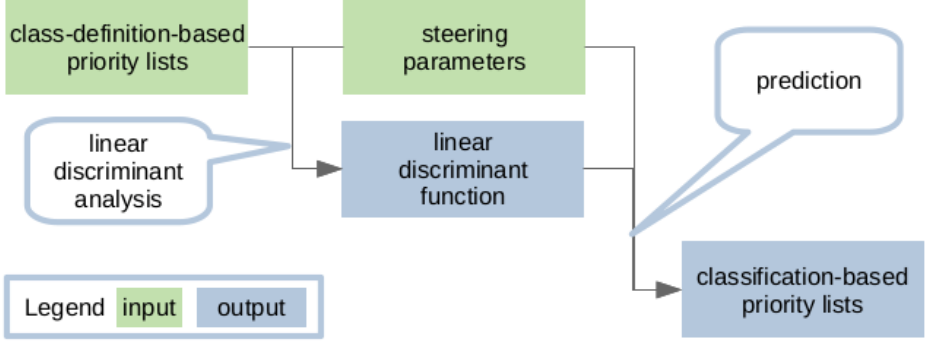
Figure 2. Obtaining a linear discriminant function and the classification-based priority lists from the class-definition-based priority lists and the steering